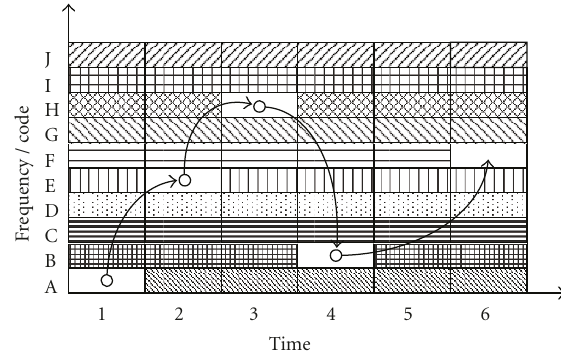
Figure 1: Cognitive Radio Operation. The arrows show the movement of secondary clients from one spectrum hole to another. A spectrum hole is used to describe unused spectrum resource. The vertical axis represents the unit of spectrum resource. For WiMAX and LTE, spectrum resource is classified by frequency while for W- CDMA(UMTS), the spectrum is classified by